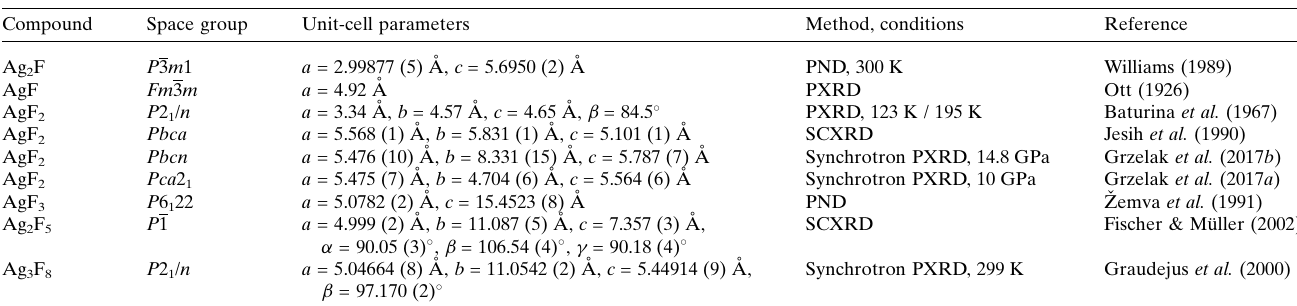
Table 1 Crystal structure data of binary silver fluorides reported in the ICSD database (only one entry for each crystalline phase is